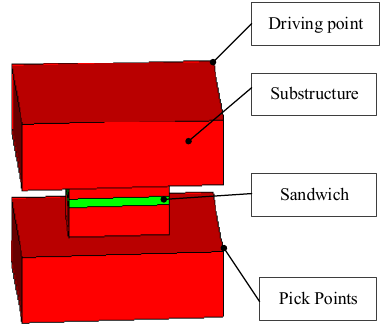
Figure 9. Theoretical model.